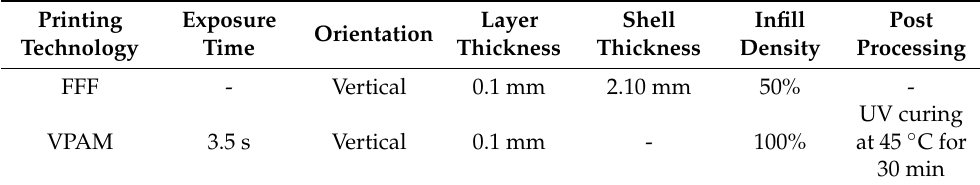
Table 2. Printing process parameters for FFF and